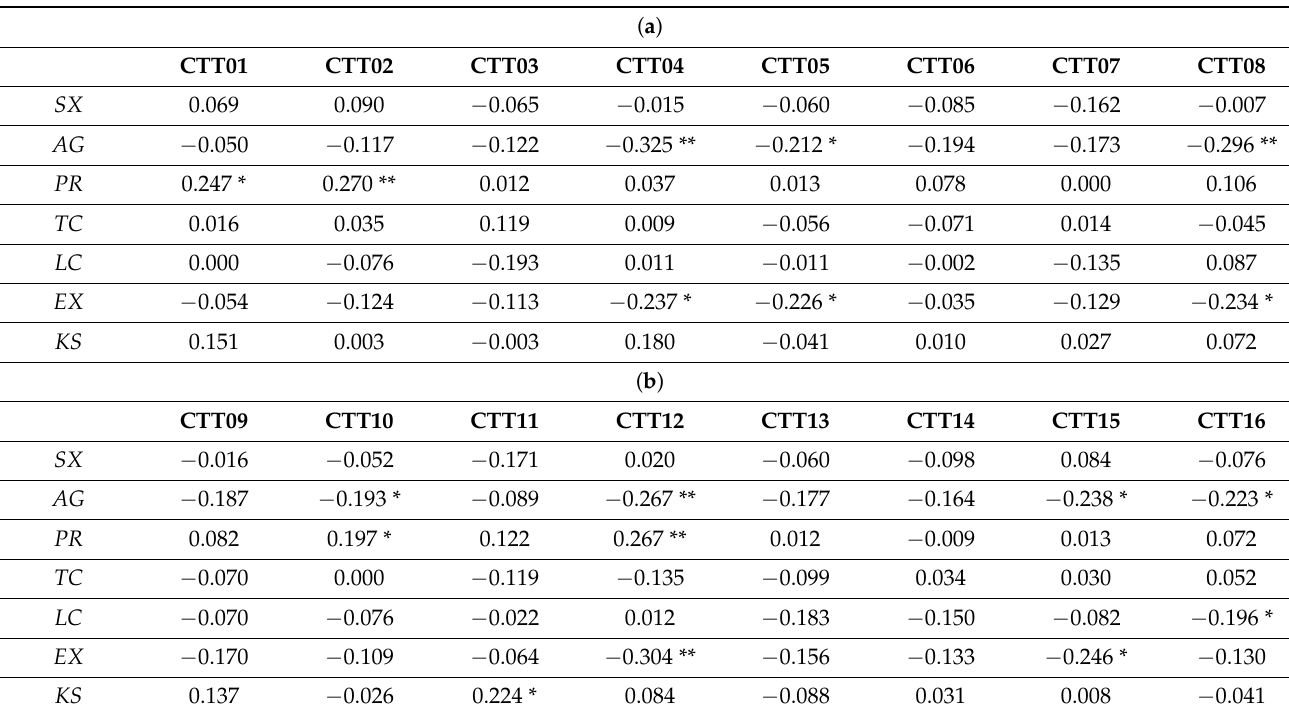
Table A9. ( a , b ) Spearman correlation matrix.: use of content creation tools.